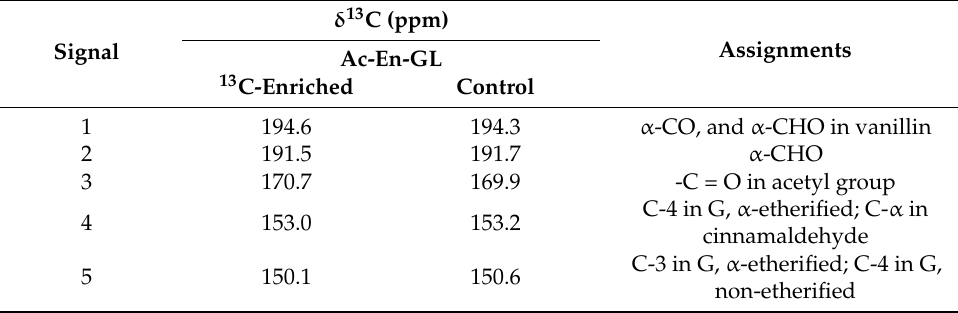
Figure 4. 13 C-NMR spectra of Ac-En-GL and Ac-En-GL-[ 13 C- 2 H] fractions from ginkgo CW-DHP. Table 5. Assignments of 13 C-NMR spectra of Ac-En-GL from ginkgo